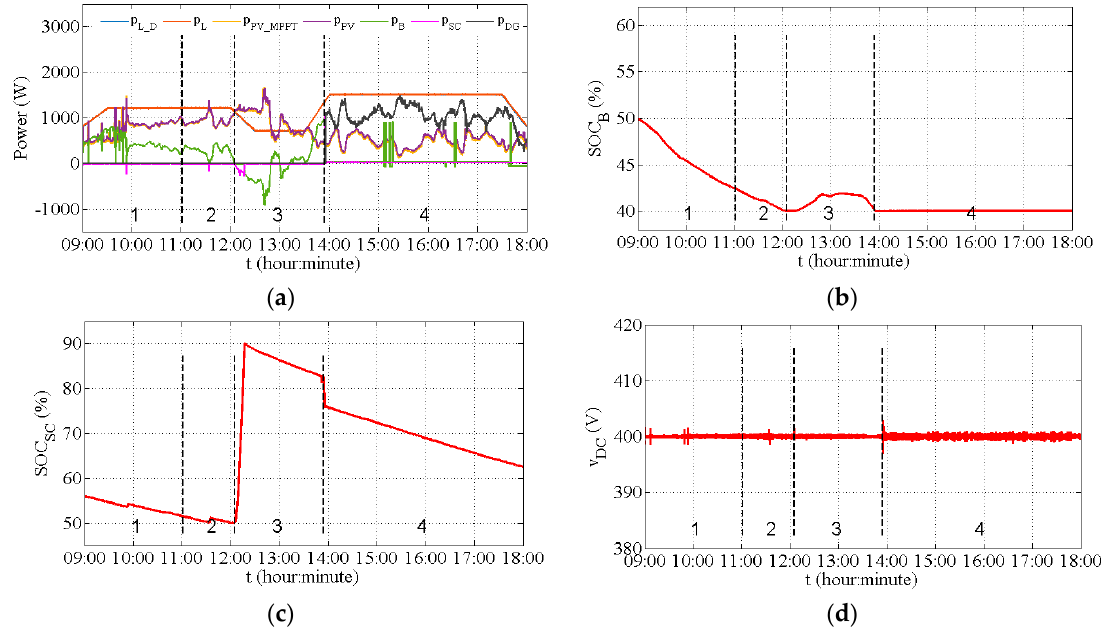
Figure 7. Experimental results of test 1 with DG load-following mode: ( a ) DC microgrid power evolutions, ( b ) SOC evolution of battery bank, ( c ) SOC evolution of the SC, and ( d ) DC bus voltage.